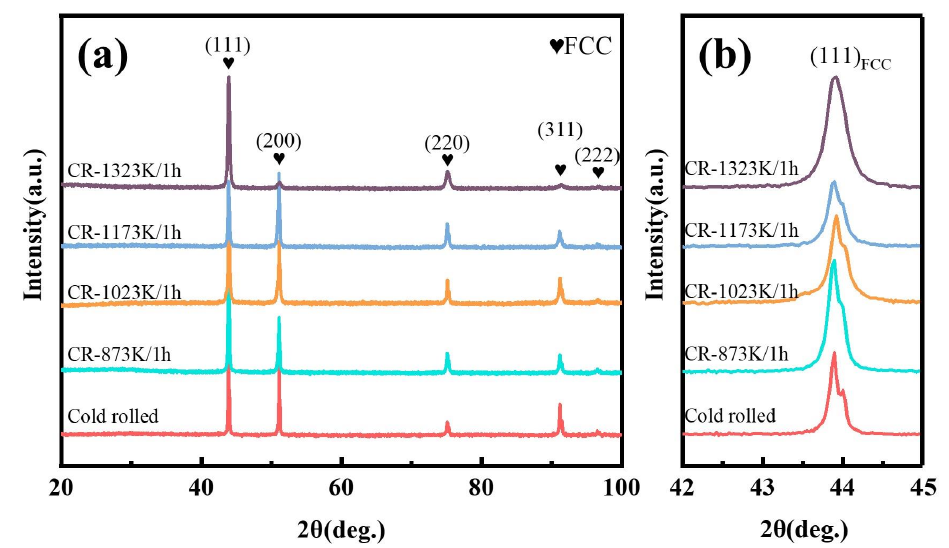
Figure 2. ( a ) XRD patterns of CR, CR‑873/1, CR‑1023/1, CR‑1173/1, and CR‑1323/1 Ni 2 FeCr samples; ( b ) Zoom‑in (111) FCC diffraction peaks.